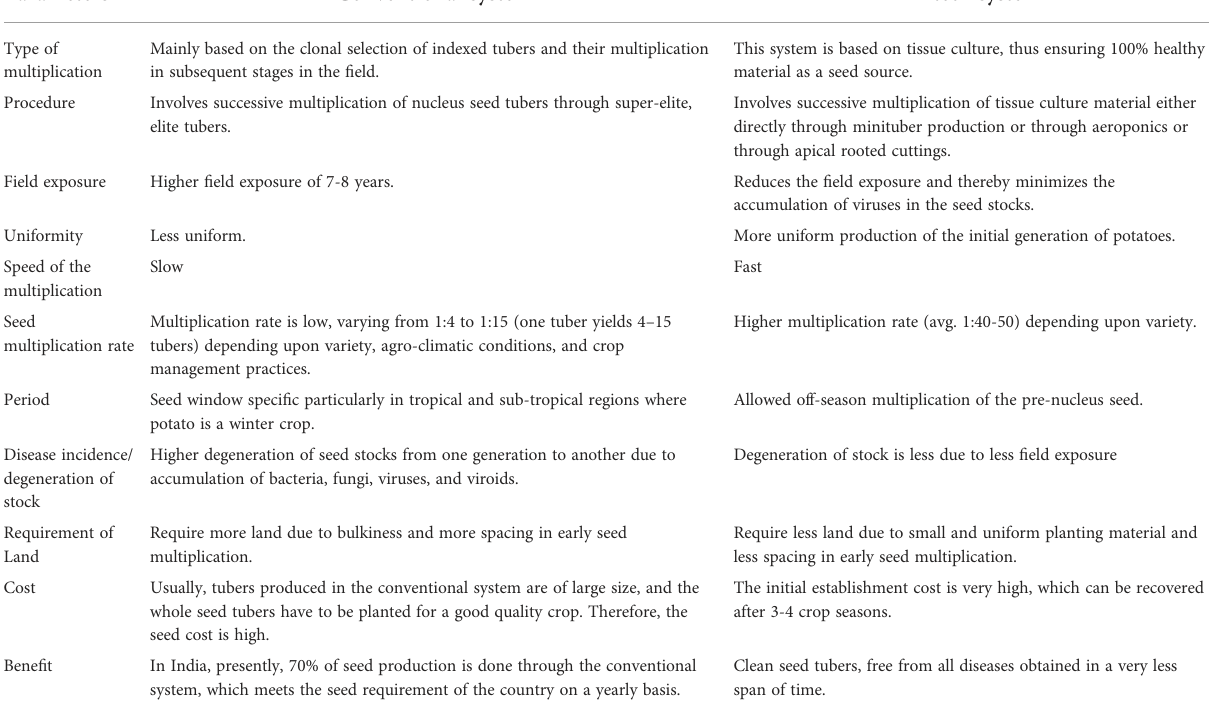
TABLE 1 Conventional vis-à-vis hi-tech system of seed potato production. Parameters Conventional system Hi-tech